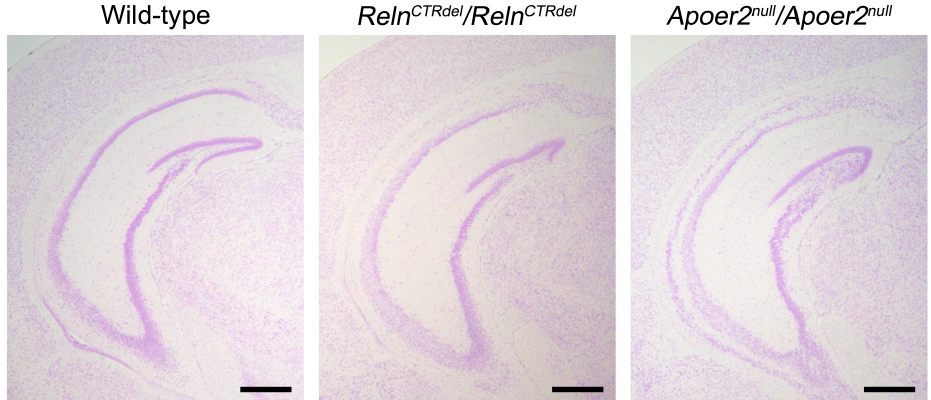
Figure A2. Enlarged images of panels selected from Figure 5 are shown. ( A ) The right color panel of Figure 5A. Scale bars, 100 µm. ( B ) The right color panel of Figure 5B. Scale bars, 100 µm. ( C ) The right panel of Figure 5D. Arrows indicate cells with elongated shape at the FDJ. Scale bars, 50 µm. ( D ) The right color panel of Figure 5E. Scale bars, 100 µm.